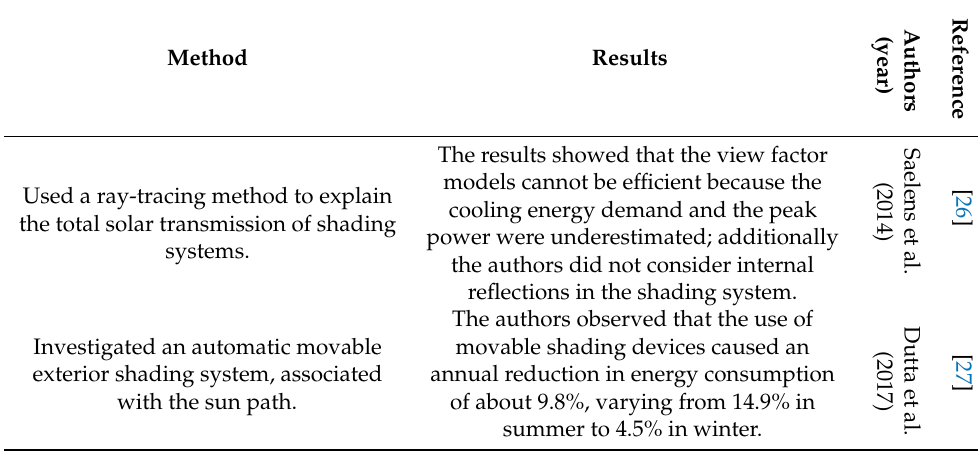
Table 1. Selected research and